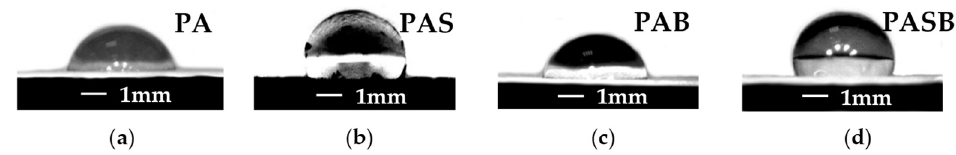
Figure 7. The surface contact angle measurements of samples ( a ) PA, ( b ) PAS, ( c ) PAB, and ( d )